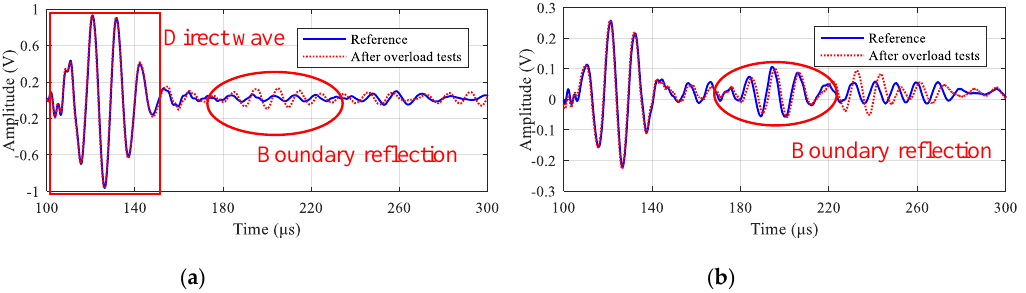
Figure 18. Signal comparison results of path 2-5 and 1-4 before and after overload tests. ( a ) Path 2-5. ( b ) Path 1-4.